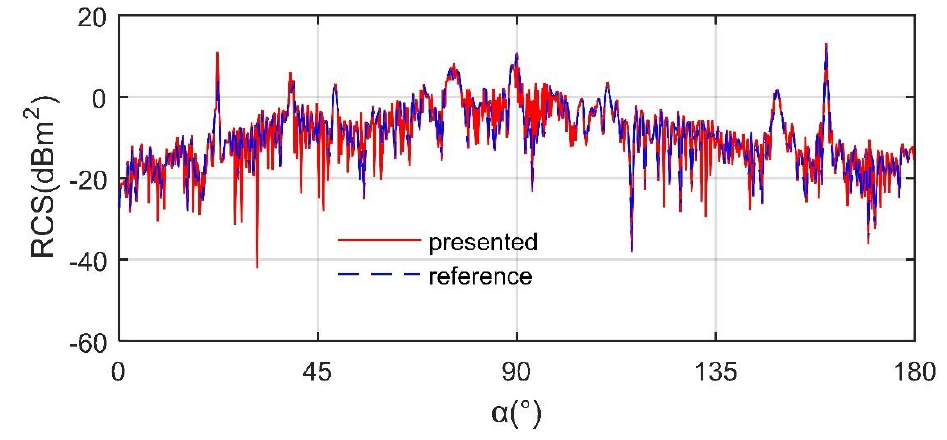
Figure 4. Verification of the RCS of the aircraft, where α n = 0° , α m = 180°, β = 10°, F rh =5 GHz, and A s = 20°.